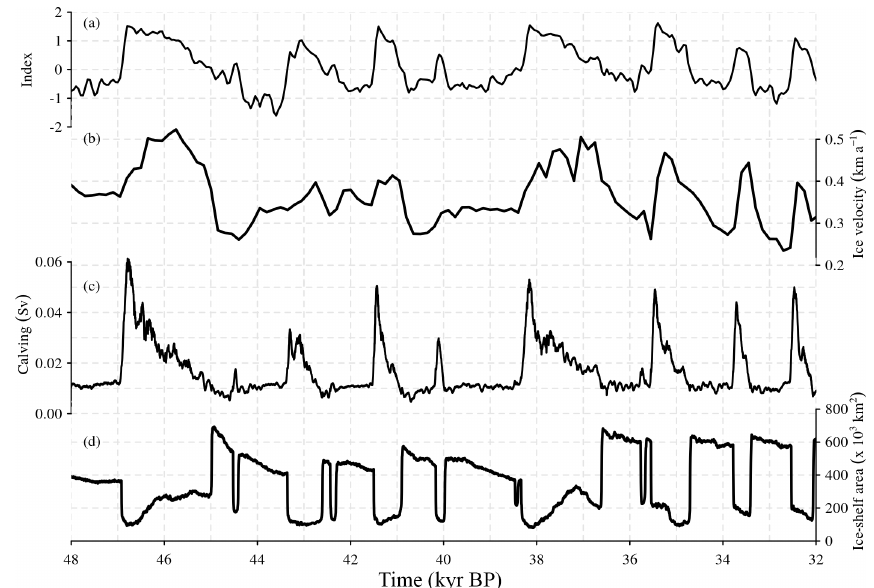
Figure 9. MIS 3 period. Temporal component of the millennial-scale climatic forcing ( β (cid:63) index), ice velocities in the Bjørnøyrenna Basin (calculated as mean values over the entire basin in kilometers per annum), calving rate (Sv) and ice-shelf area (10 3 km 2 ) in the OCN srf